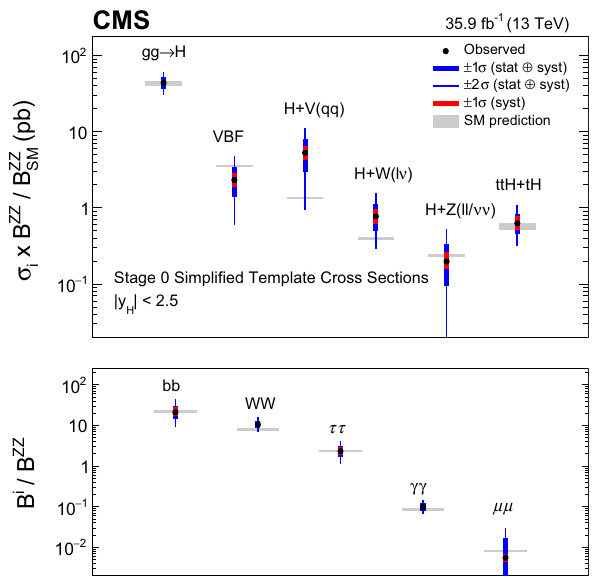
Fig. 8 Summary of the stage 0 model, ratios of cross sections and branching fractions. The points indicate the best fit values, while the error bars show the ± 1 σ and ± 2 σ uncertainties. The ± 1 σ uncertain- ties on the measurements considering only the contributions from the systematic uncertainties are also shown. The uncertainties in the SM predictions are indicated